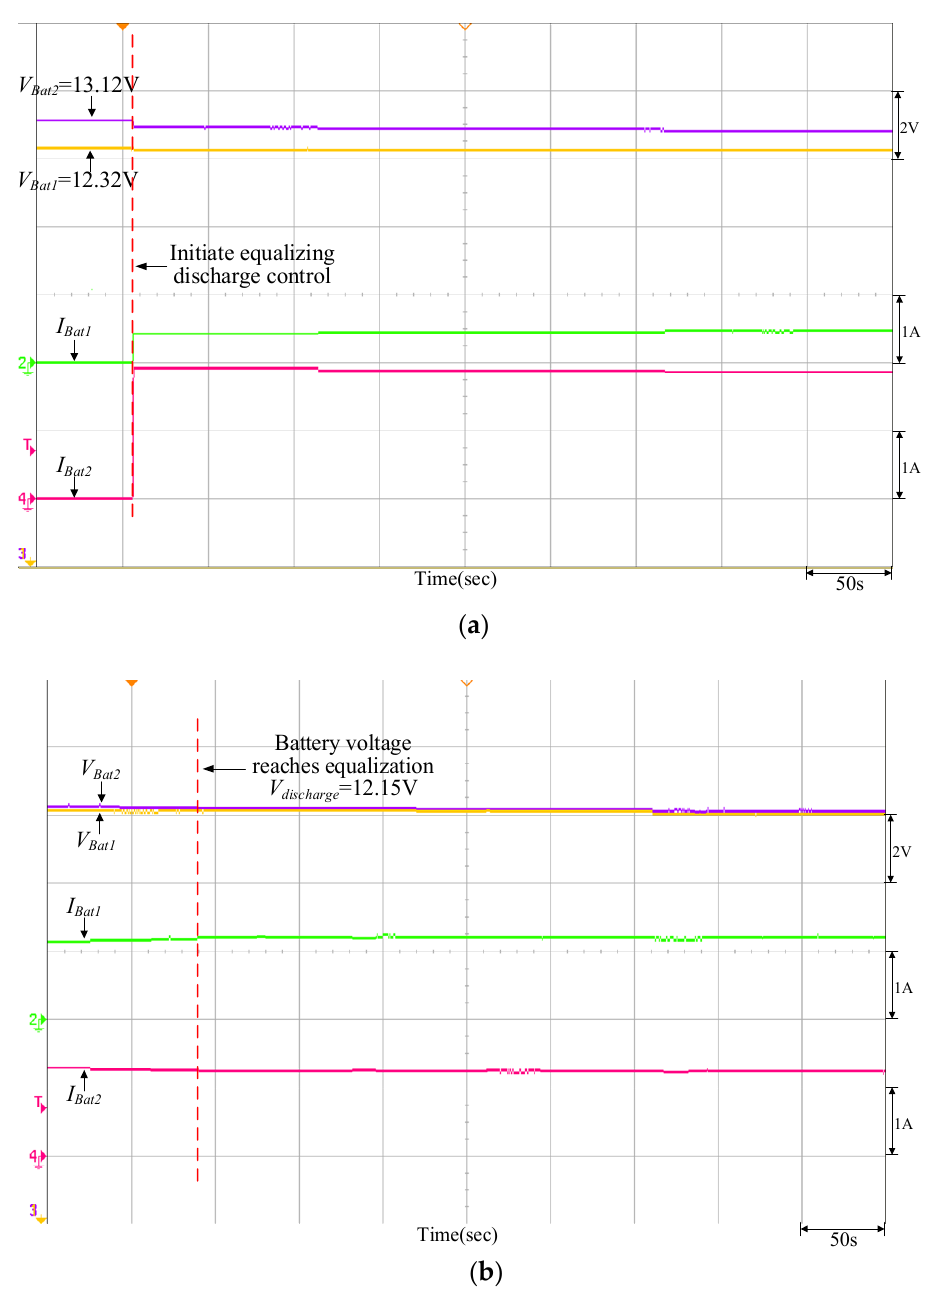
Figure 16. P-V characteristic curve of MPPT when the PVMA output power is at 200 W.